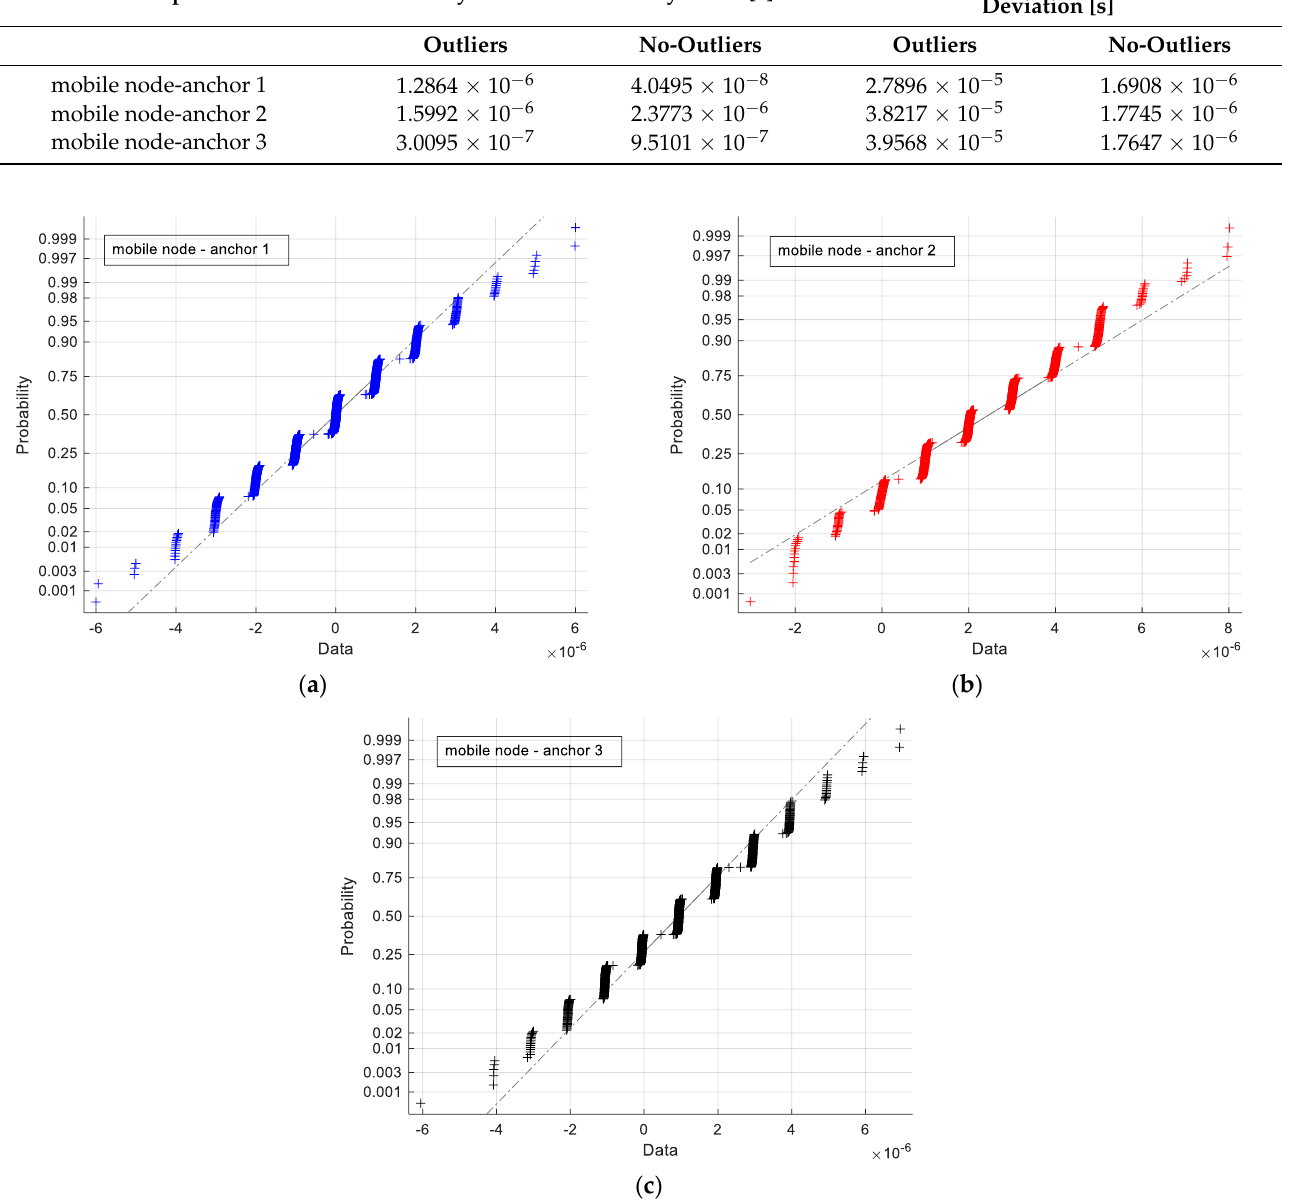
Figure 3. ( a – c ) show the normal probability plot of the time-synchronization delay waveforms (out- liers removed) between each considered couple of